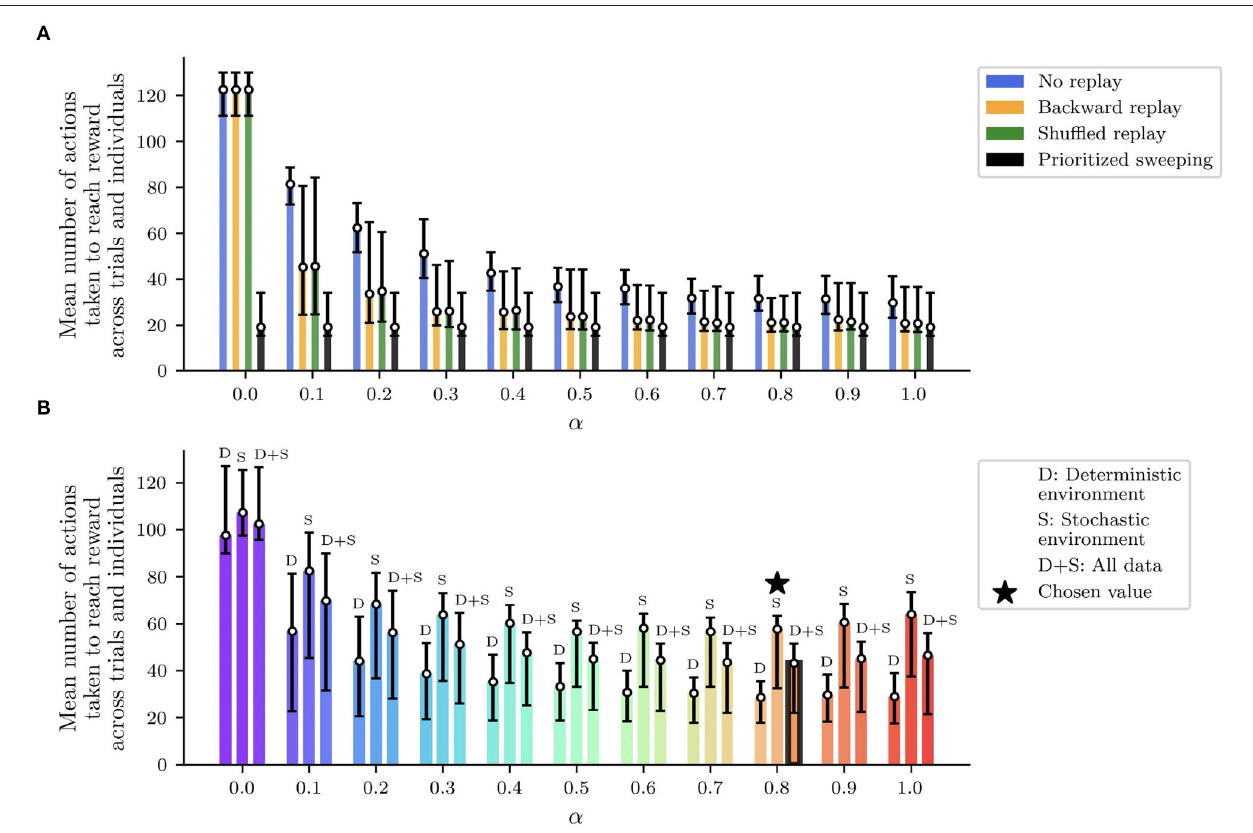
FIGURE 4 | Performed analysis to find out the best learning rate α for all the replay strategies and the two environments (deterministic and stochastic). For different values of α , the figure shows the first, median, and third percentile of the number of actions to get to the reward, over 100 agents completing the simulated experiment over 50 trials. The average minimum number of model iterations to get to the reward is found for α equal to 0.8, and it was used for all the presented experiments ( Table 2 ). (A) Performances of the tested algorithms across the α values in the deterministic version of the maze. (B) Final selection of α considering the mean performances between the deterministic and the stochastic version of the